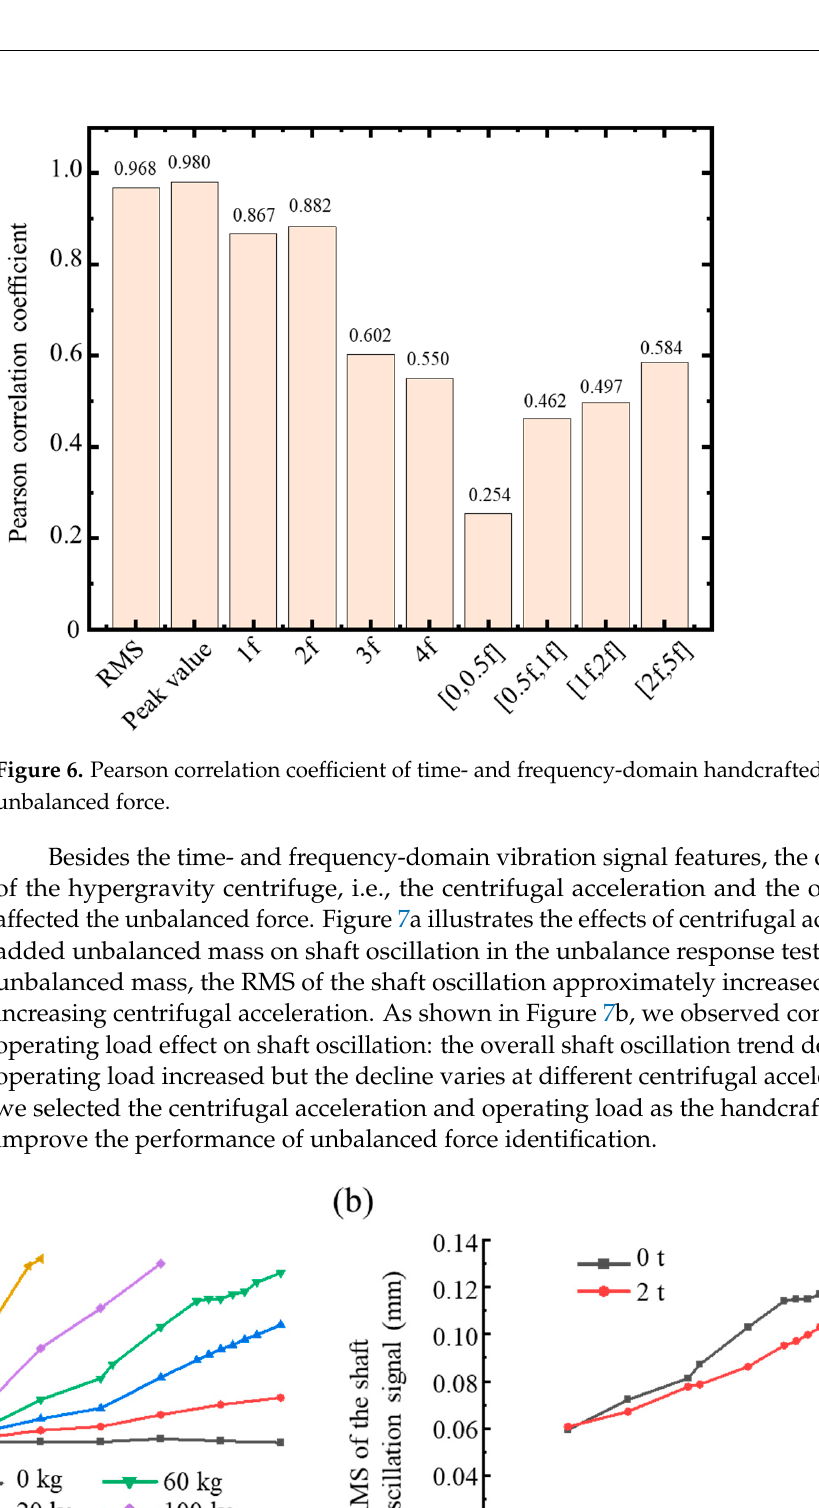
Figure 7. E ff ects of centrifugal acceleration on the RMS of shaft oscillation. ( a ) RMS of the shaft oscillation at di ff erent added unbalanced masses (0 t operating load). ( b ) RMS of the shaft oscillation at 0 t and 2 t operating loads (60 kg added unbalanced mass).